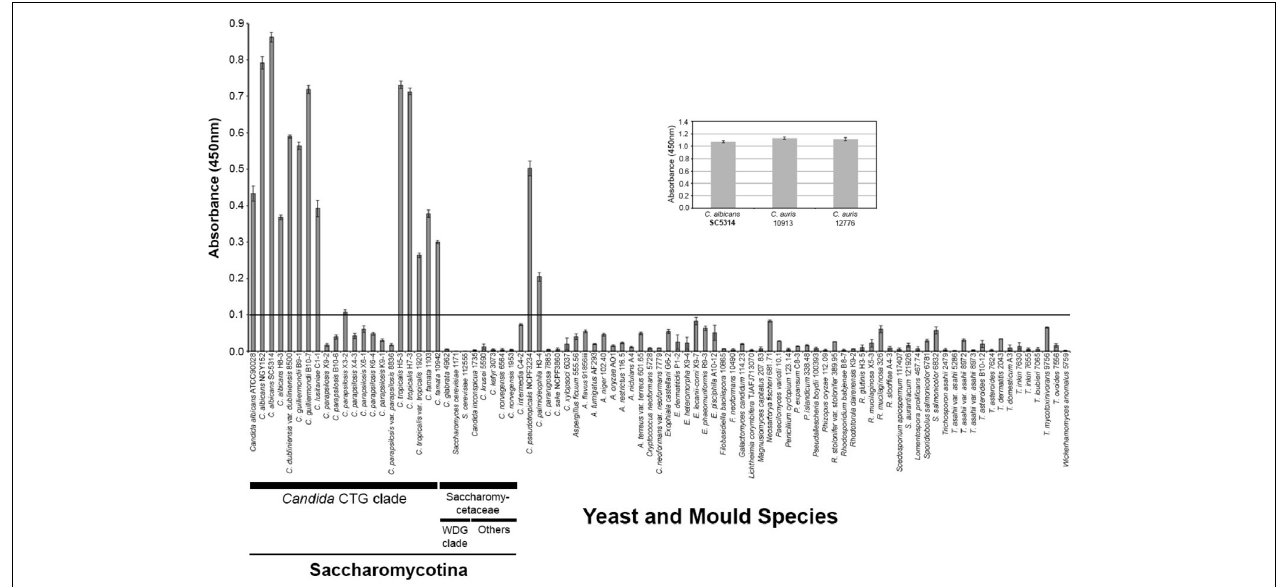
FIGURE 1 | Specificity of mAb MC3 determined by Enzyme-Linked Immunosorbent Assay tests of surface washings containing water-soluble antigens from Candida species and related and unrelated yeasts and molds. ELISA absorbance values at 450 nm for soluble antigens from Candida species in the CTG clade and Saccharomycetaceae, the emerging human pathogen Candida auris (inset), and other related and unrelated yeasts, yeast-like fungi and molds of clinical significance. Wells were coated with 60 µ g protein/mL buffer. Bars are the means of three biological replicates ± standard errors and the threshold absorbance value for the detection of antigen is ≥ 0.1 (indicated by line on